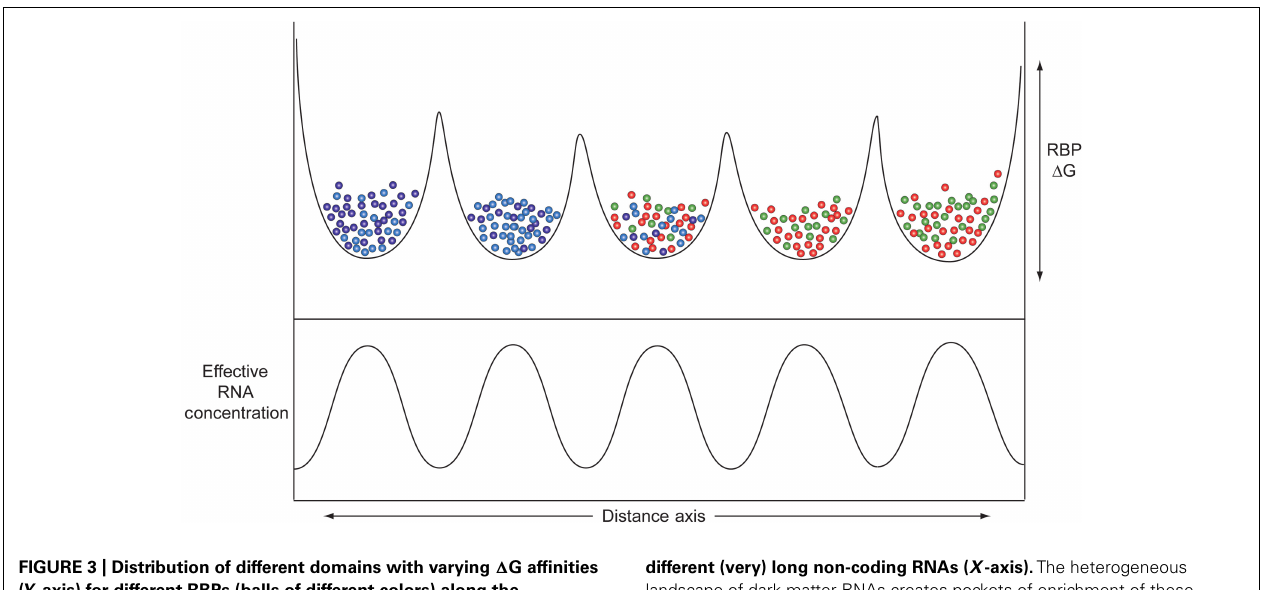
different (very) long non-coding RNAs ( X -axis). The heterogeneous landscape of dark matter RNAs creates pockets of enrichment of these different RBPs.